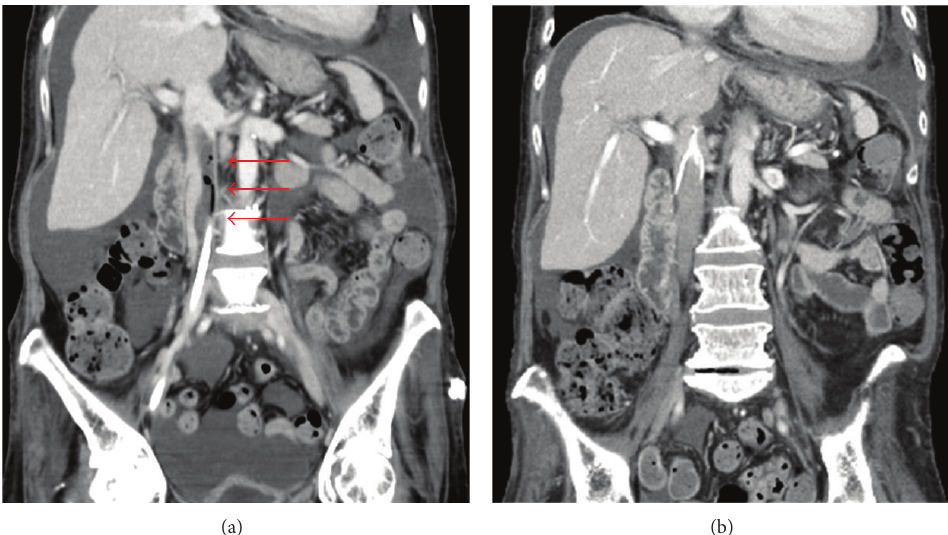
Figure 1: (a) Contrast-enhanced computed tomography (CT) demonstrated nonobstructive thrombus ( arrows ) with air density extending from the CVC via the right femoral vein to the suprarenal IVC, just above the renal vein confluence. (b) Follow-up CT established that there was no IVC thrombus or thrombus in the filter.